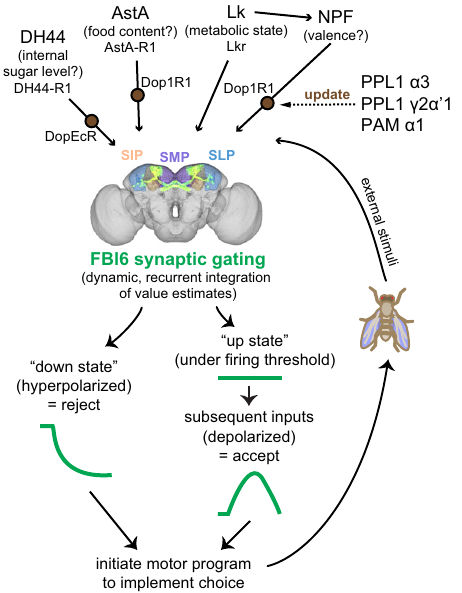
Fig. 6 Proposed synaptic gating model for recurrent integration of updated input signals by FBl6 neurons for decision making. Upstream neuropeptidergic neurons assess value estimates of metabolic state (Lk), internal sugar level (DH44), available food content (AstA), and food valence (NPF), and project to SMP, SIP, and SLP higher brain regions. In these brain regions, dopaminergic neurons recurrently modulate neuropeptidergic neurons to update value estimates encoded by them when animal navigates in its environment, senses, and consumes food. Context-dependent updated value estimates are dynamically received from neuropeptidergic neurons by FBl6 neurons in the SMP, SIP, SLP regions. FBl6 neurons are bistable, transitioning between a hyperpolarized “ down state ” and a resting state associated “ up state ” . When FBl6 neurons are in “ down state, ” choice outcome is rejection. When FBl6 neurons receive inputs to reach “ up state ” with membrane potential just under fi ring threshold, subsequent inputs are integrated non-linearly. If this non-linear summation crosses the threshold to depolarize FBl6 neurons, choice outcome is acceptance. In sum, FBl6 neurons dynamically integrate and gate the fl ow of information to downstream circuits, initiating motor programs that implement the choice outcome. This transient dynamic representation of choice is constantly updated over time with animal ’ s experience, internal state, and sensory environment. Dynamic updating of these signals is achieved by extensive recurrent circuitry between the inputs and outputs of the decision ensemble. Standardized brain with SMP, SLP, SIP brain regions and neurons expressed by 84C10-GAL4 were created at